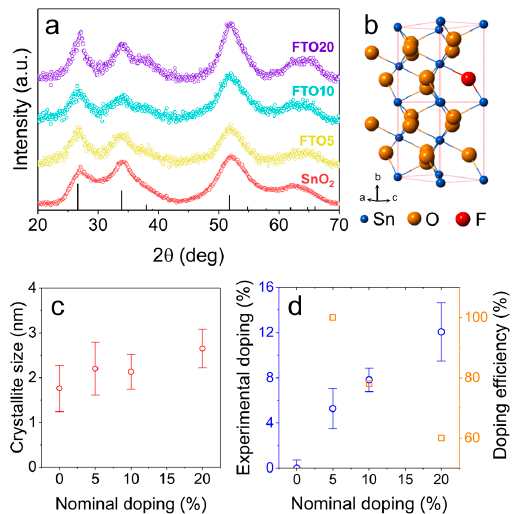
Figure 1. (a ) X-ray diffraction (XRD) patterns for the undoped SnO 2 and F-doped SnO 2 (FTO) nanocrystals (NCs) prepared in this study. The expected diffraction peak positions for cassiterite tin dioxide are reported at the bottom. ( b ) Schematic representation of the SnO 2 lattice. ( c ) Crystallite size as a function of the doping level. ( d ) Experimental F doping and average doping efficiency as a function of the nominal doping level.